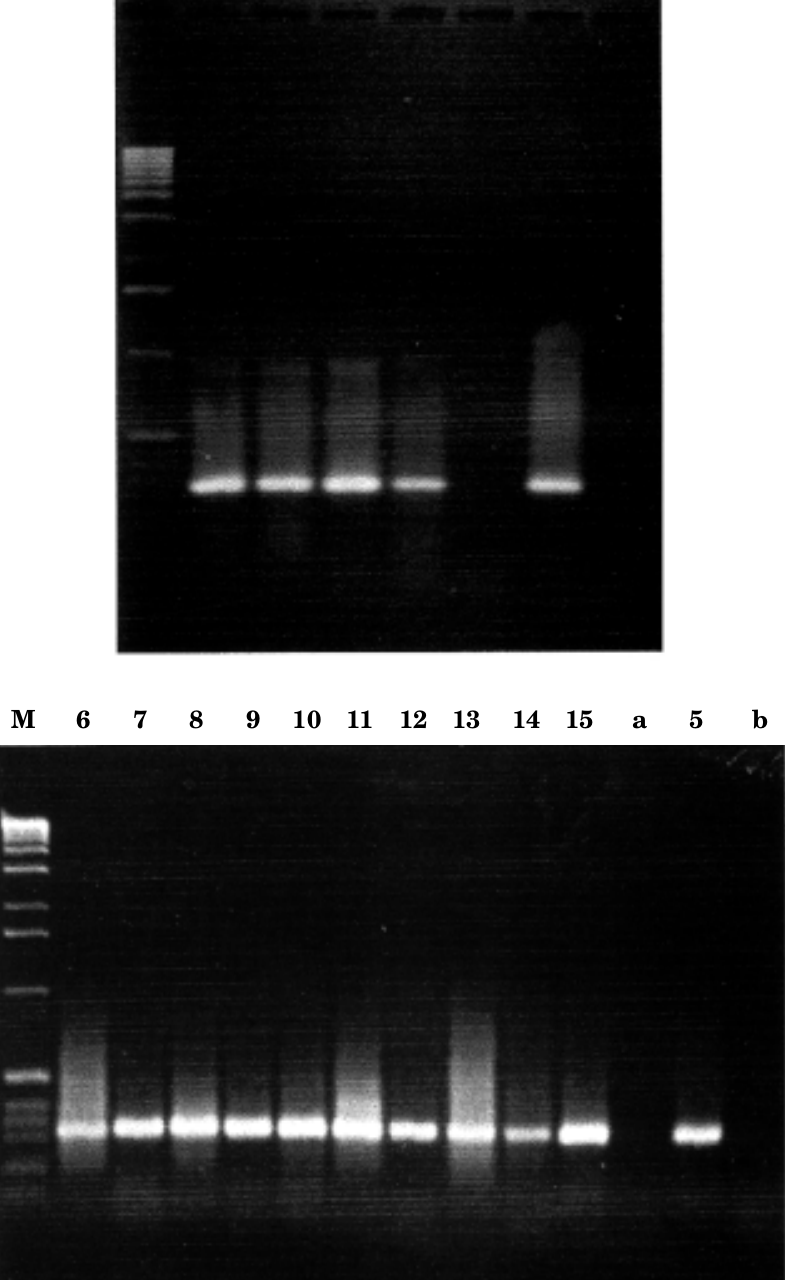
Fig. 3. Detection of HSVd by RT-PCR. Samples that gave a positive hybridisation signal by non-isotopic molecular hybridisation were amplified by RT-PCR and the products analysed by 1% agarose gel electrophoresis. Apricot samples from Morocco (lanes 1, 2 and 3); from Turkey (lane 4); positive control consisting of HSVd-infected Japanese plum cv. Taiyo (lane 5) ; samples from Cyprus (lanes 6-12); from Greece (lanes 13-15). Lanes a and b, uninfected apricot extract and water controls respectively. DNA molecular weight markers were loaded in lane